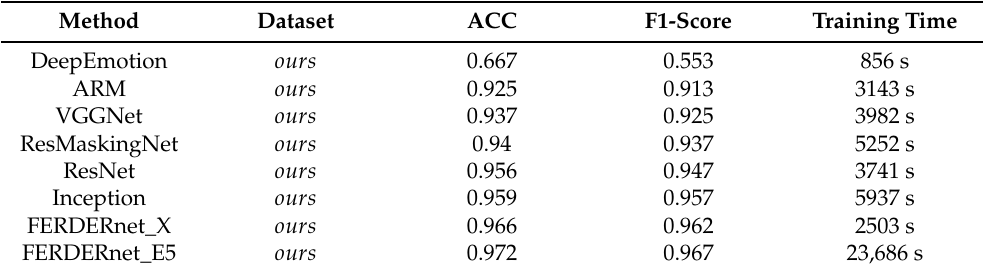
Table 3. Comparison with the state-of-the-art methods on the on-road driver facial expression dataset.